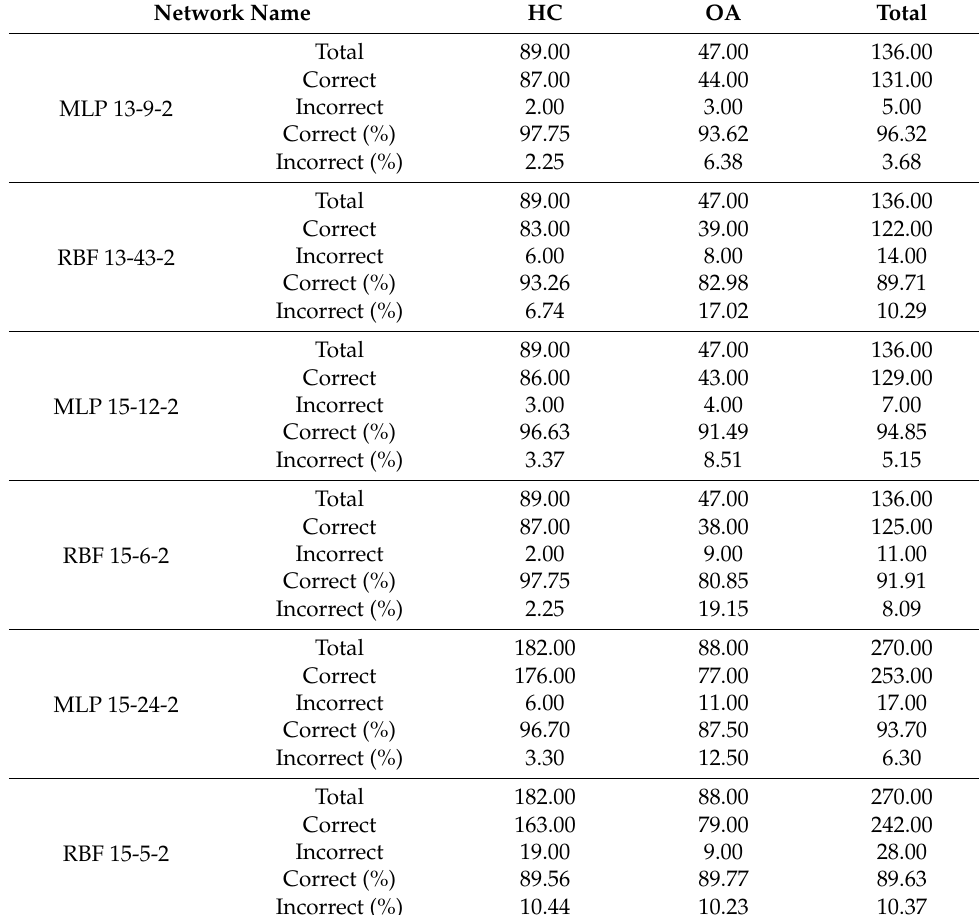
Table 3. Summary of classification accuracy of MLP and RBF networks for variant I, II and III.